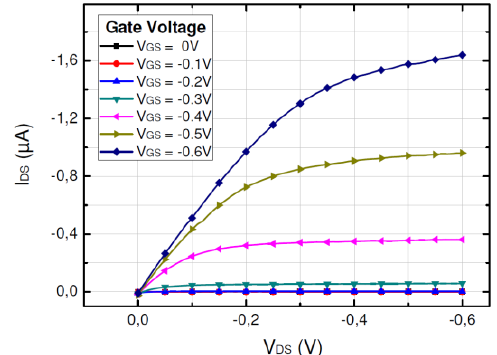
Figure 4. I DS vs. V DS graph of the WG-FET for various V GS voltages with DI-Water as the water droplet.